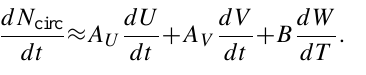
the whole period of the reanalysis (1948–2007) and the pe- riod for which the European horizontal visibility data is avail-